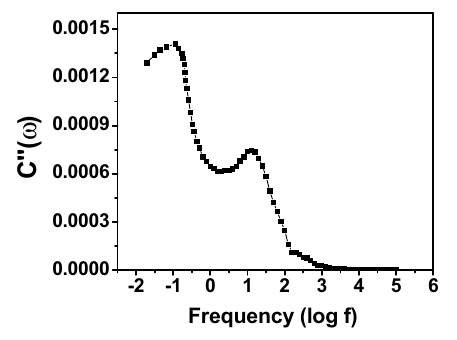
Fig. 9 Bode plot of SnO 1:3)